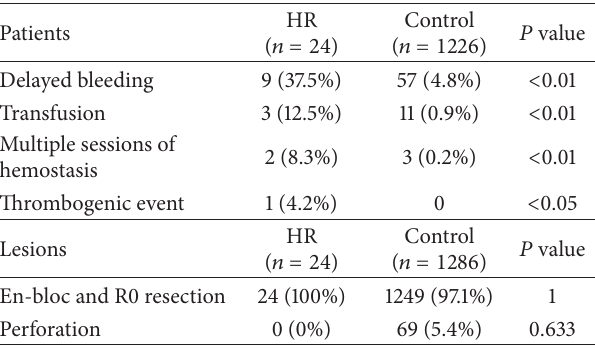
Table 4: Summary of endoscopic outcomes and complications associated with ESD under HR.